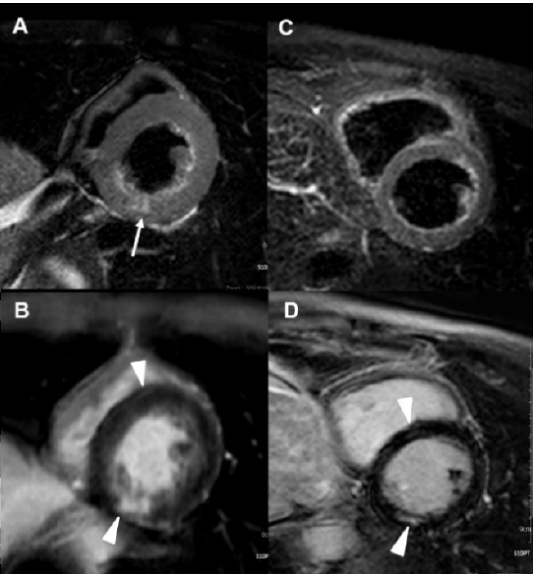
Figure 2. Serial cMRI images in case no. 2 before and after RTX therapy. ( A , B ) Pre-RTX treatment cMRI images revealed patchy edema in short-axis T2-weighted images ( A , white arrows) and post- gadolinium delayed enhancement images ( B , white arrowheads). ( C , D ) After induction and two courses of maintenance therapy, resolved myocardial edema ( C ) and some mid-wall fibrosis at the sepal and inferior walls of LV mid-cavity ( D , white arrowheads).